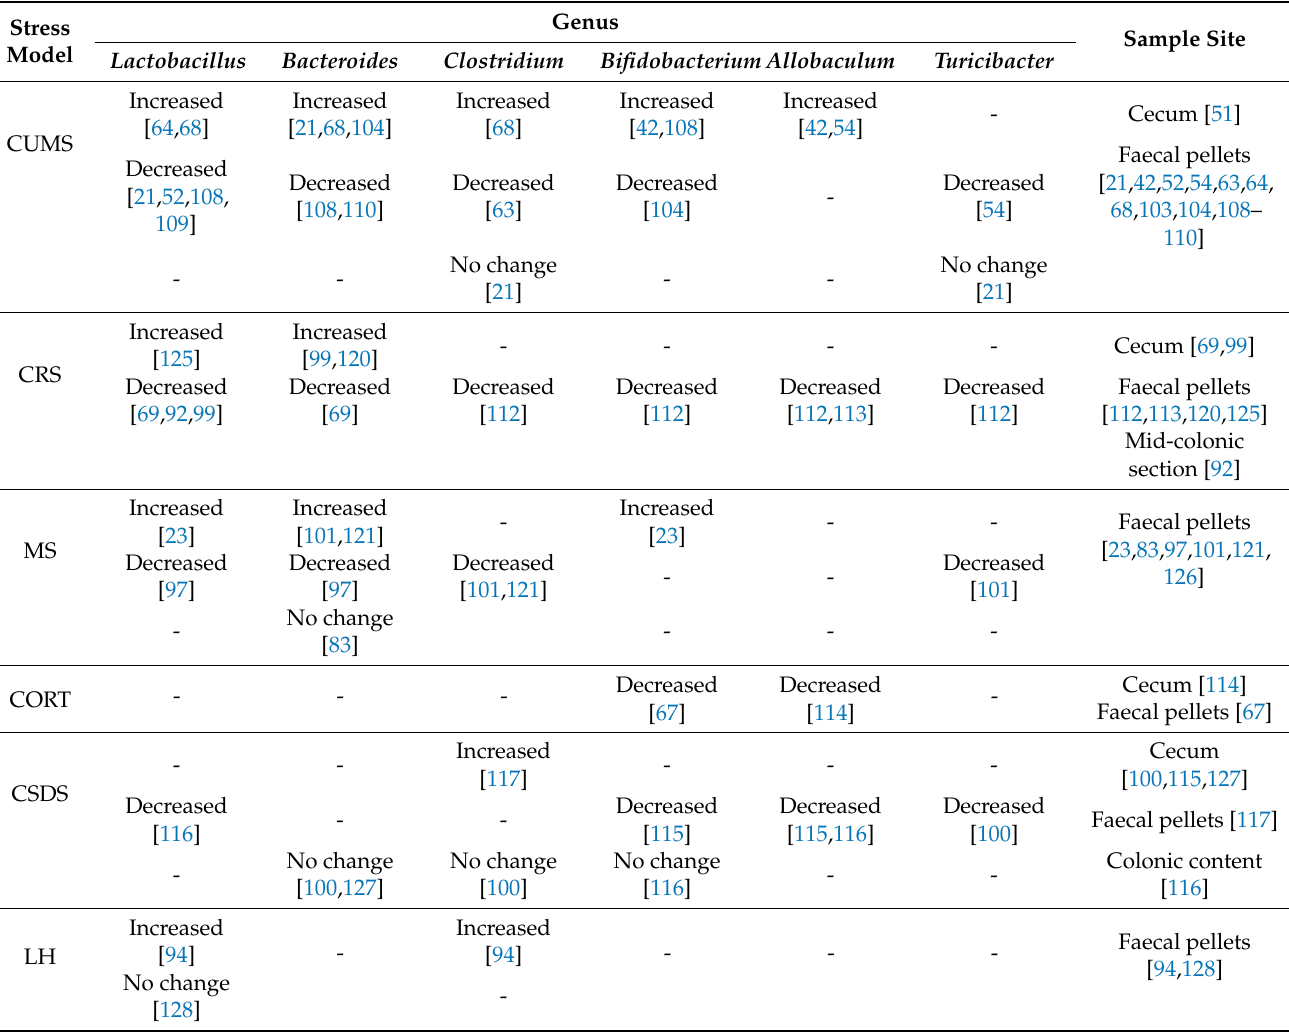
Table 2. Comparisons of gut microbiota alterations at the genus level and the site of sample collection across male animal models of stress and